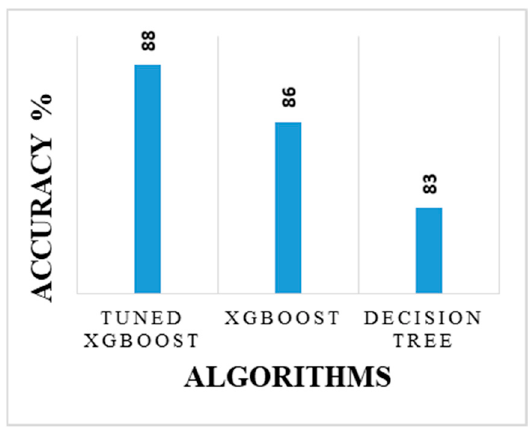
Figure 5. Comparison of accuracy results.